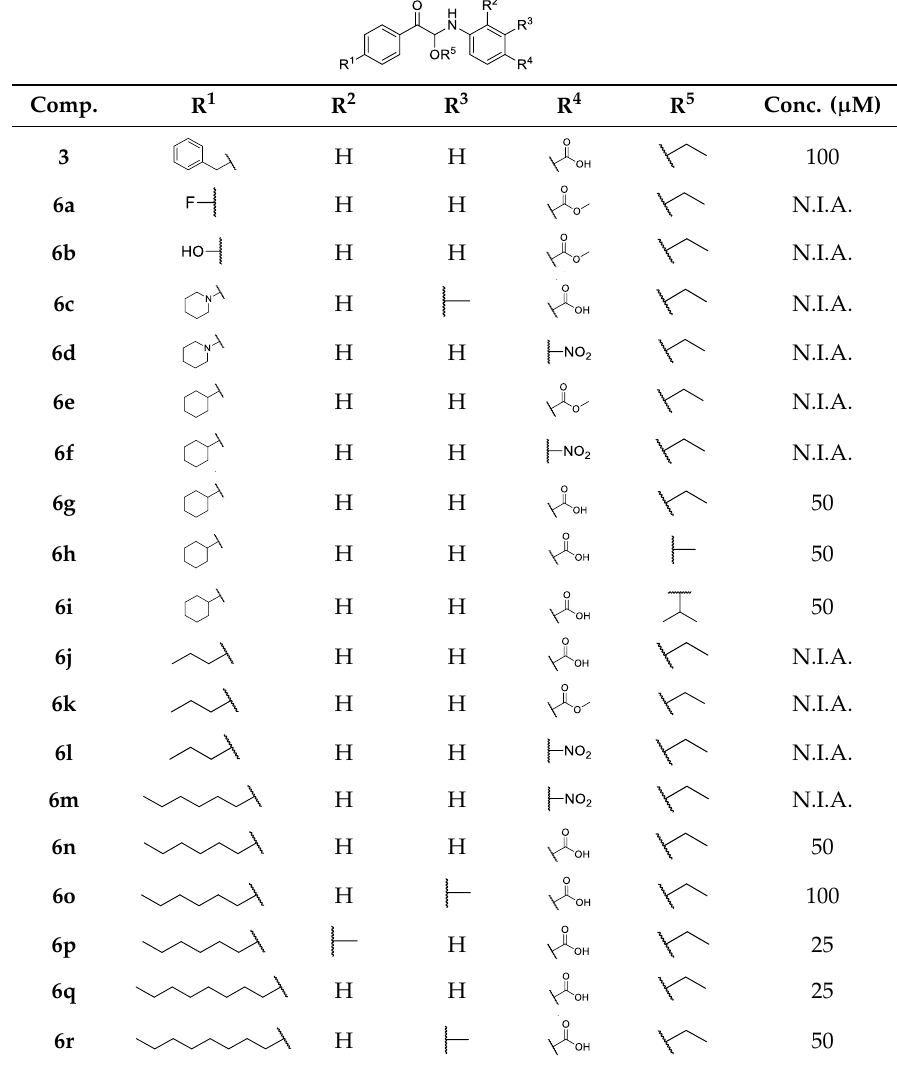
Table 3. The activities of 8a – 8d and 9a – 9d in combination with 2 μ g ·mL −1 colistin against the growth of BL21(DE3) expressing mcr-1 .